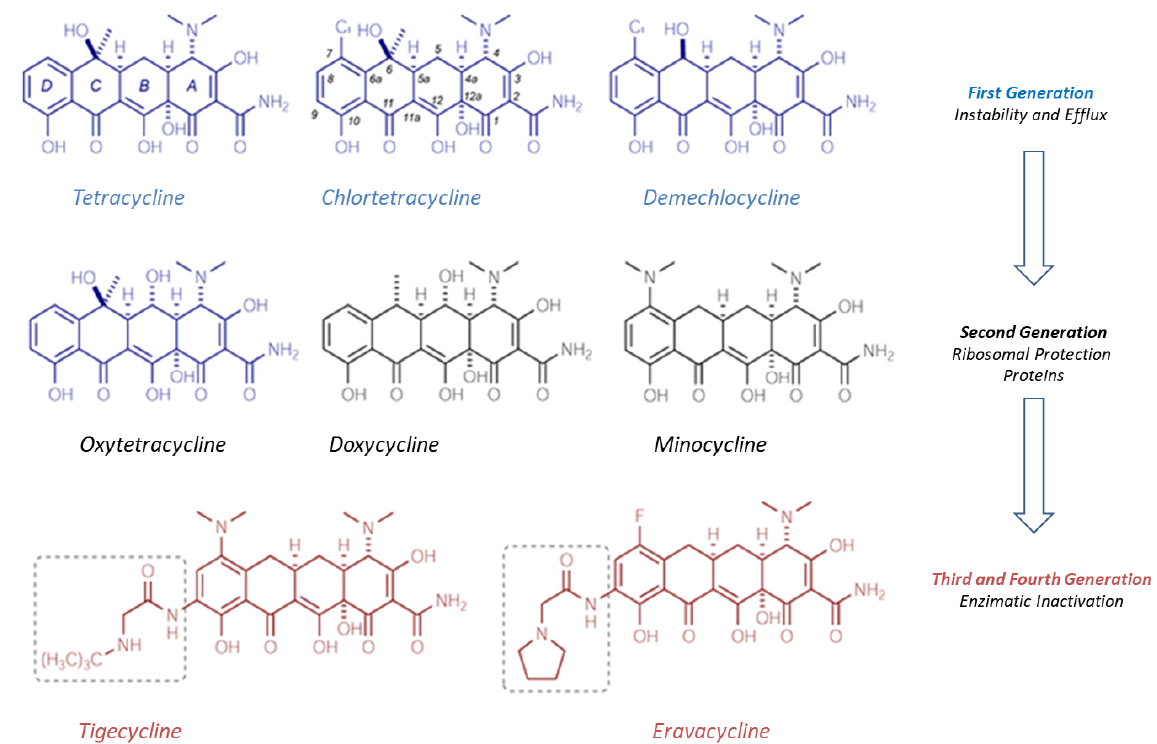
Figure 3. Different generations of tetracyclines and antibiotic resistance.